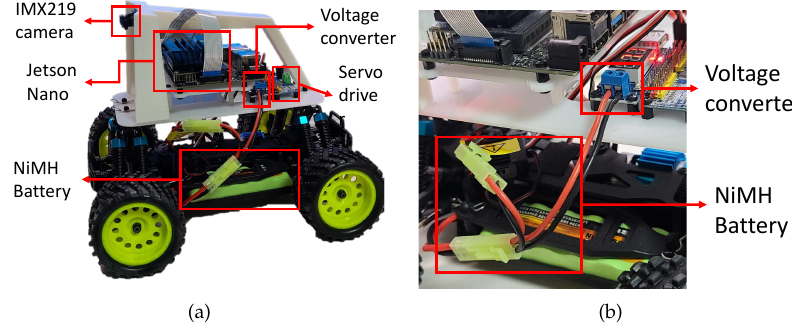
Figure 8. ( a ) DonkeyCar structure, ( b ) DonkeyCar battery